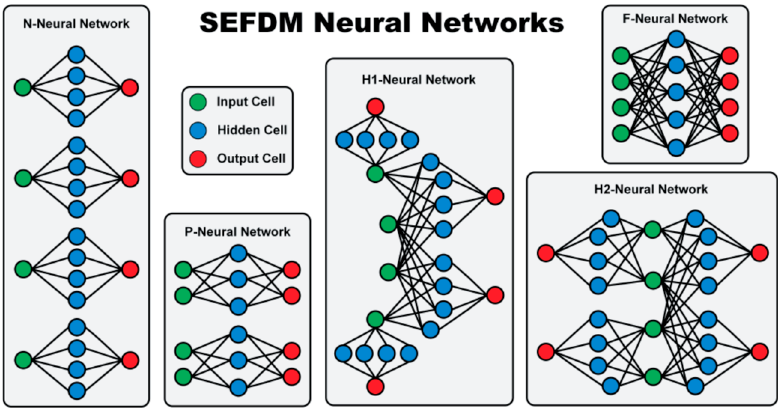
Figure 18. Neural network structures for inter-carrier interference (ICI) suppression in spectrally e ffi cient frequency division multiplexing (SEFDM) systems.